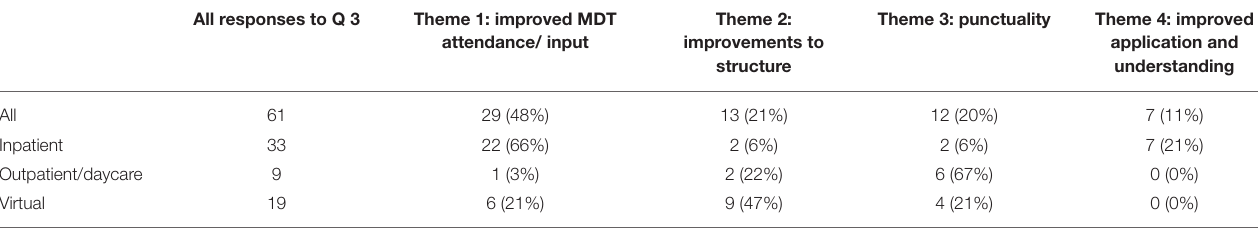
TABLE 4 | A table showing % themes identified from responses across the huddles to question 3 “what could be improved in the huddle.”